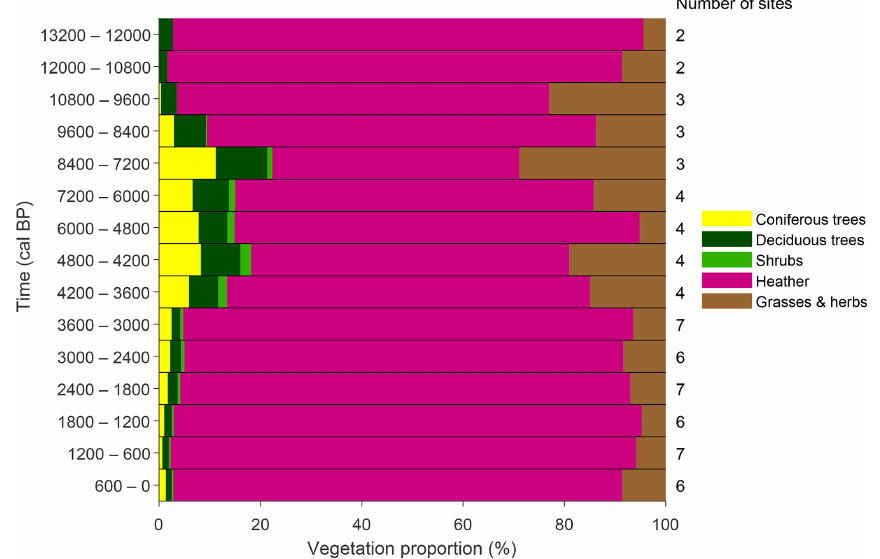
Figure 6. Reconstructed vegetation proportions for the study area using the REVEALS model, based on seven pollen cores.